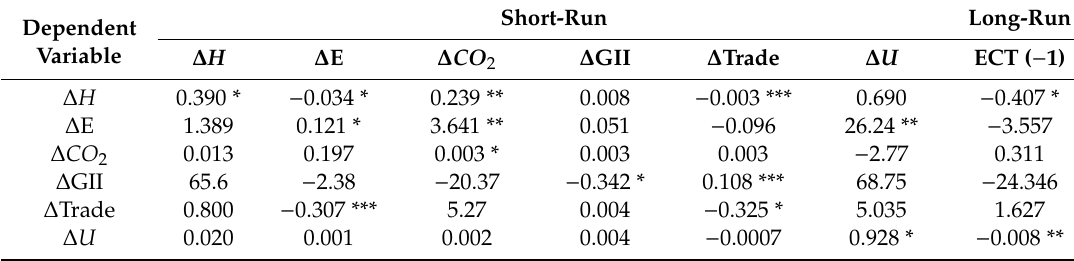
Table 9. The empirical results of Granger causality